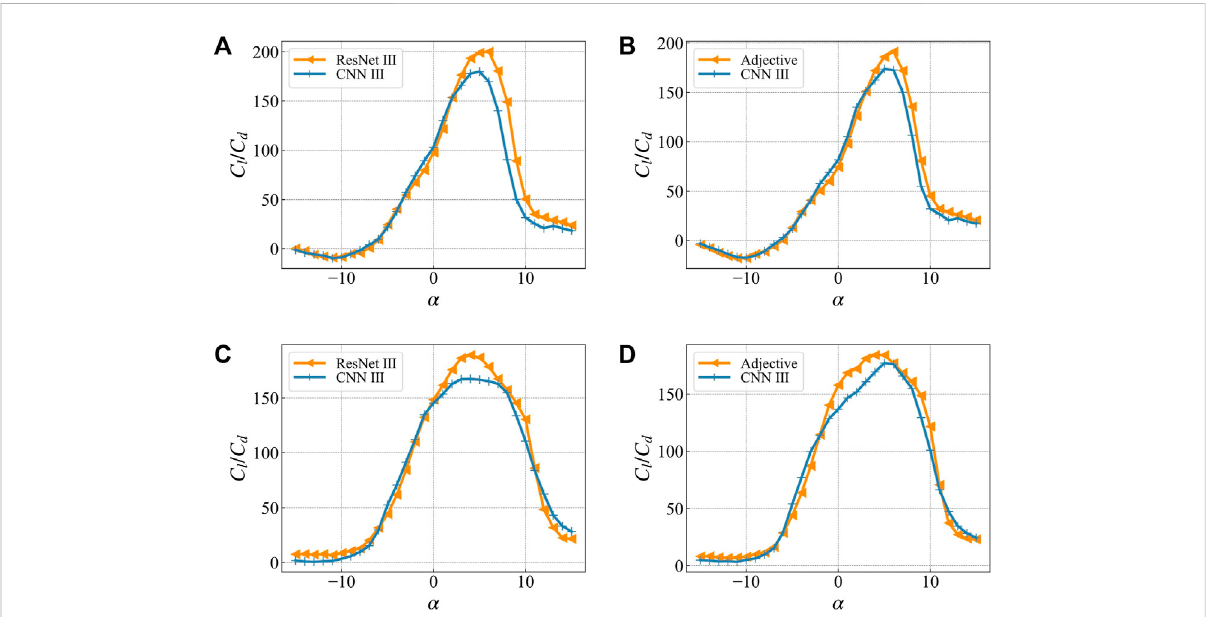
FIGURE 12 The optimization results are in the network participating in the optimization (ResNet Ⅲ or Adjective) and the network not participating in the optimization (CNN Ⅲ )The lift-to-dragratioprediction curvein (A) isbased ontheoptimization result ofResNet Ⅲ for single target angleof attack (B) is based on the optimization result of Adjective for single target angle of attack (C) is based on the optimization result of ResNet Ⅲ for multi-target angle of attack (D) Optimization results based on Adjective for multi-target angles of